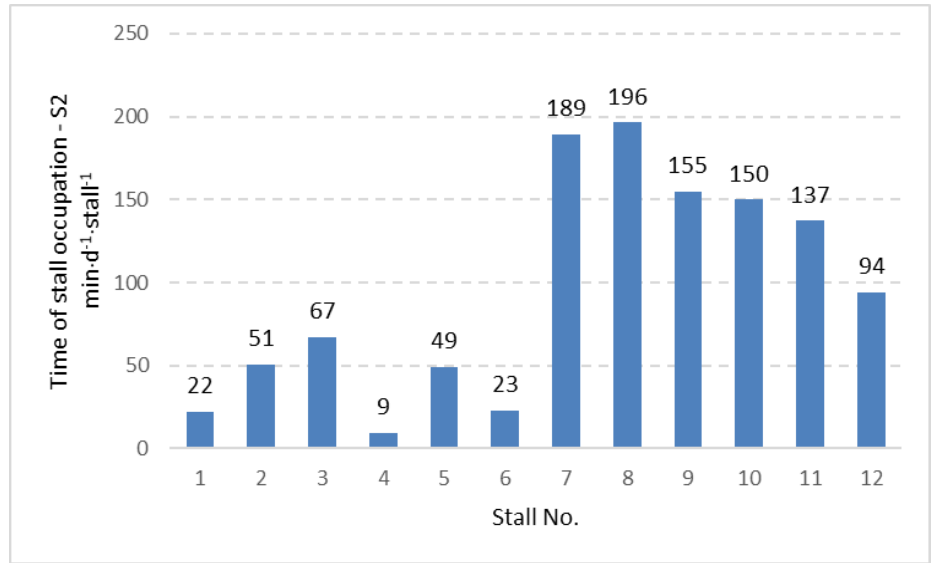
Figure 3. Distribution of time of occupation for standing with two hooves in the stall (S2) for individually considered stalls in the investigated pen.